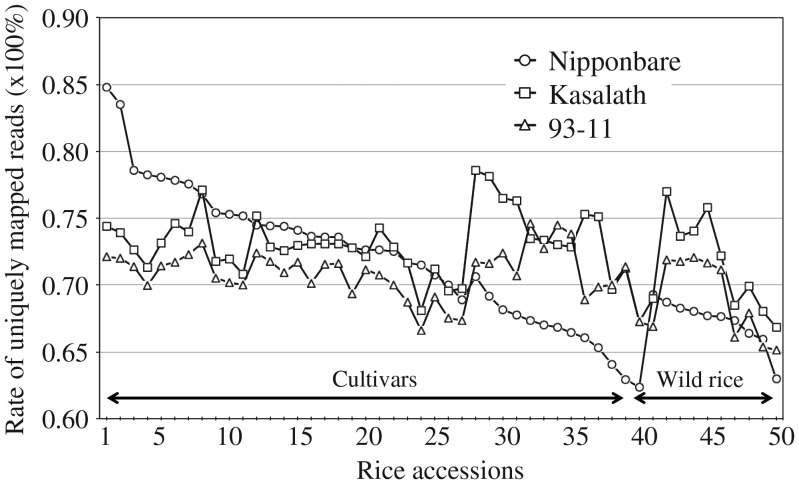
Rate of uniquely mapped NGS reads from 50 rice accessions by using Nipponbare, Kasalath, and 93-11 pseudomolecule sequences as references. Arabic numerals under the horizontal axis represent different accessions of cultivated and wild rice (see Supplementary Table S2 for details).